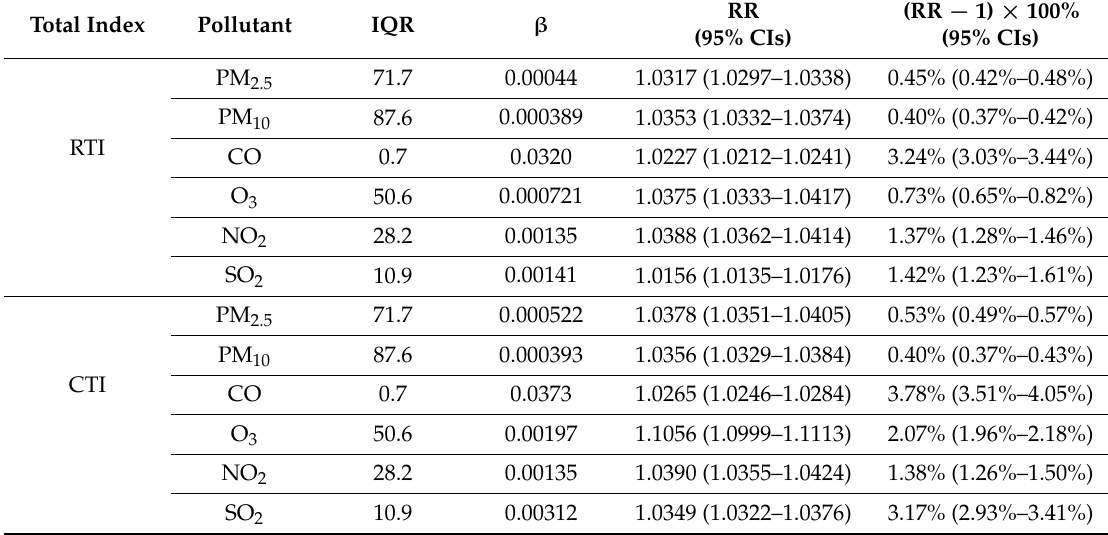
Table 7. Exposure–response assessment of the six pollutants. While the unit of CO concentration is mg/m 3 , the units of the other pollutant concentrations are µ g/m 3 . The fifth column shows relative risks when pollutant concentrations change by one unit of IQR. The sixth column shows the increases of relative risks of the health outcome per 10 µ g/m 3 (per 1 mg/m 3 for CO) increase in pollutant